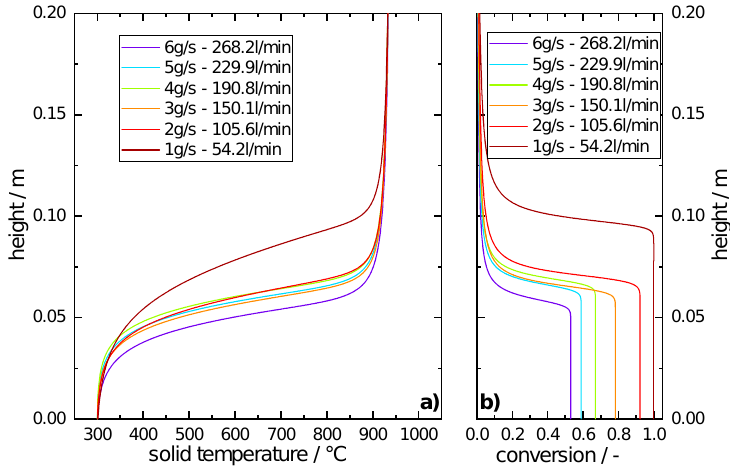
Figure 9. Solid temperatures ( a ) and conversion profiles ( b ) at a 0.2m section of the 0.7m simulated bed height with different particle and gas flow rates at steady state operation. The flow rates were chosen for optimized overall conversion of the particles obtained at the reactor outlet for the given particle mass